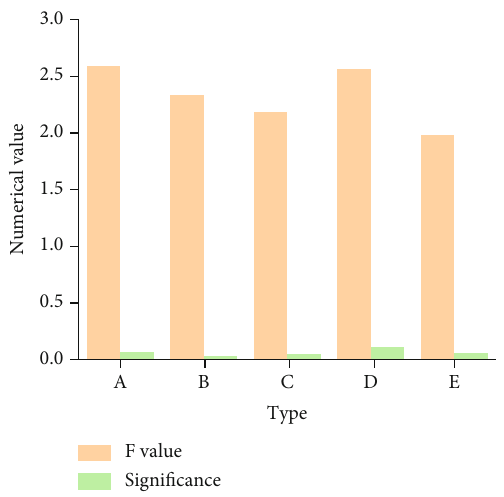
Figure 6: The results of variance analysis of the employees ’ ages (A: less than 20 years old; B: 21-30 years old; C: 31-40 years old; D: 41-50 years old; and E: over 50 years old).